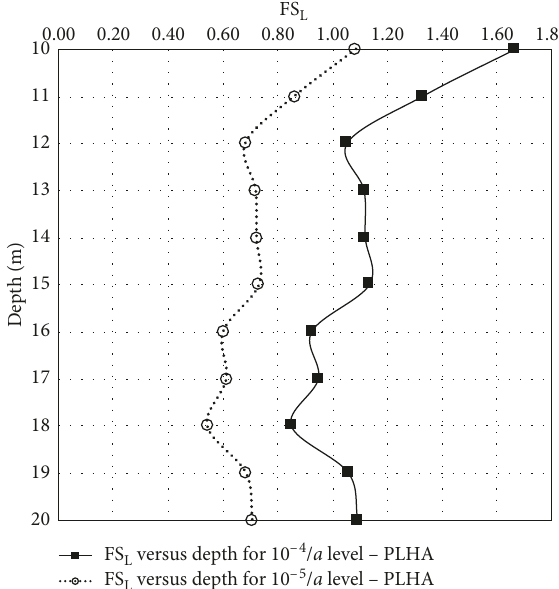
Figure 6: Distribution of FS L in the layers between 10 and 20meters depth at the